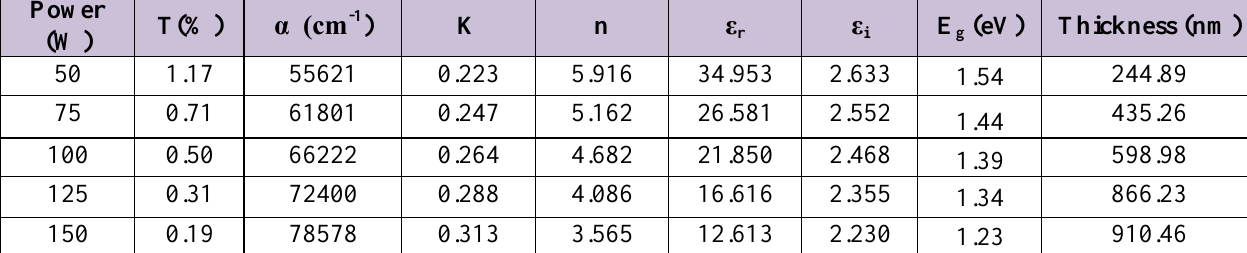
Table 1: The optical parameters for (Ti6Al4V) films at different RF power.